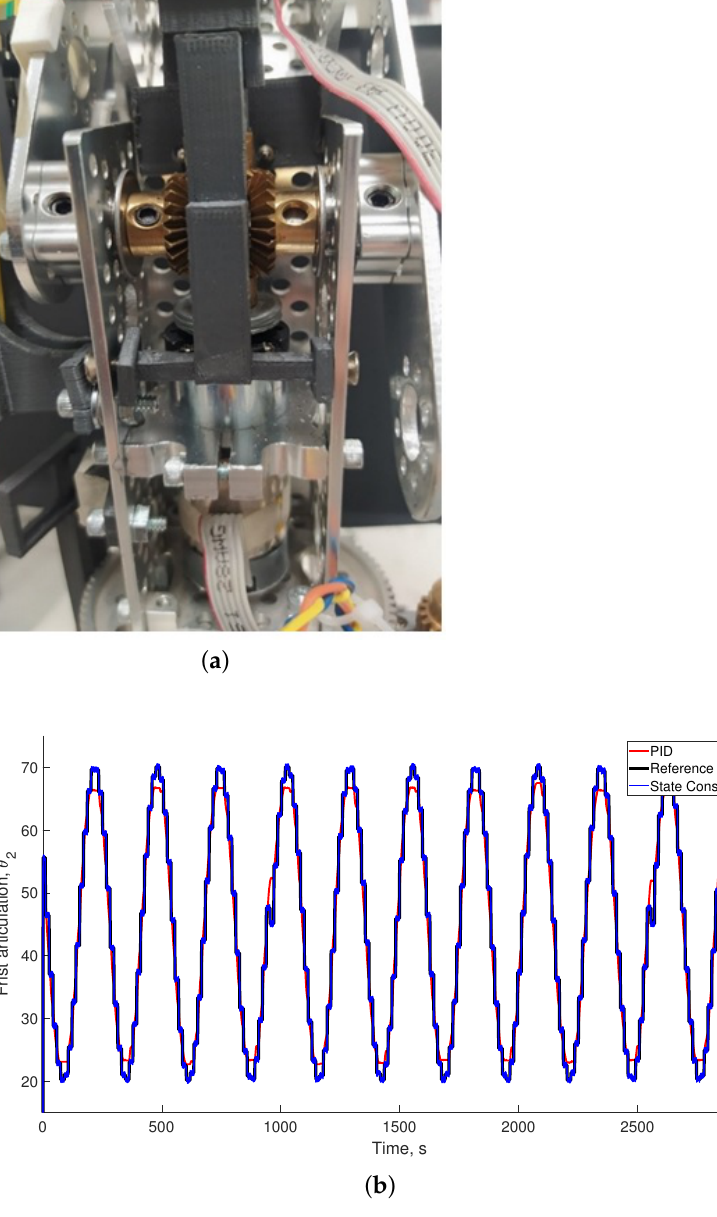
Figure 5. ( a ) Photograph of the electromechanical configuration for the second articulation θ 2 ; ( b ) comparison of the controlled motion for the second articulation ( θ 2 ) when the PID and adaptive control with state constraints are